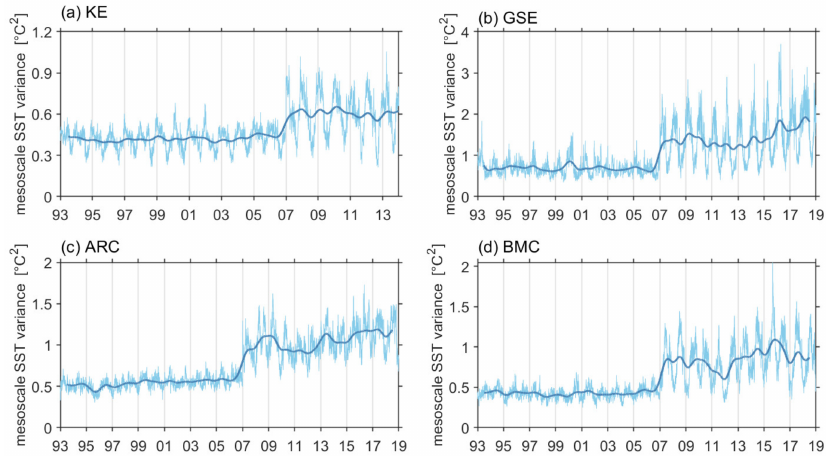
Figure 2. Time series of the mesoscale SST variance based on the OI.v2-AVHRR-only data in the regions of ( a ) KE, ( b ) GSE, ( c ) ARC, and ( d ) BMC. The thin and thick lines denote the daily and 1.5-year low-pass filtered time series,